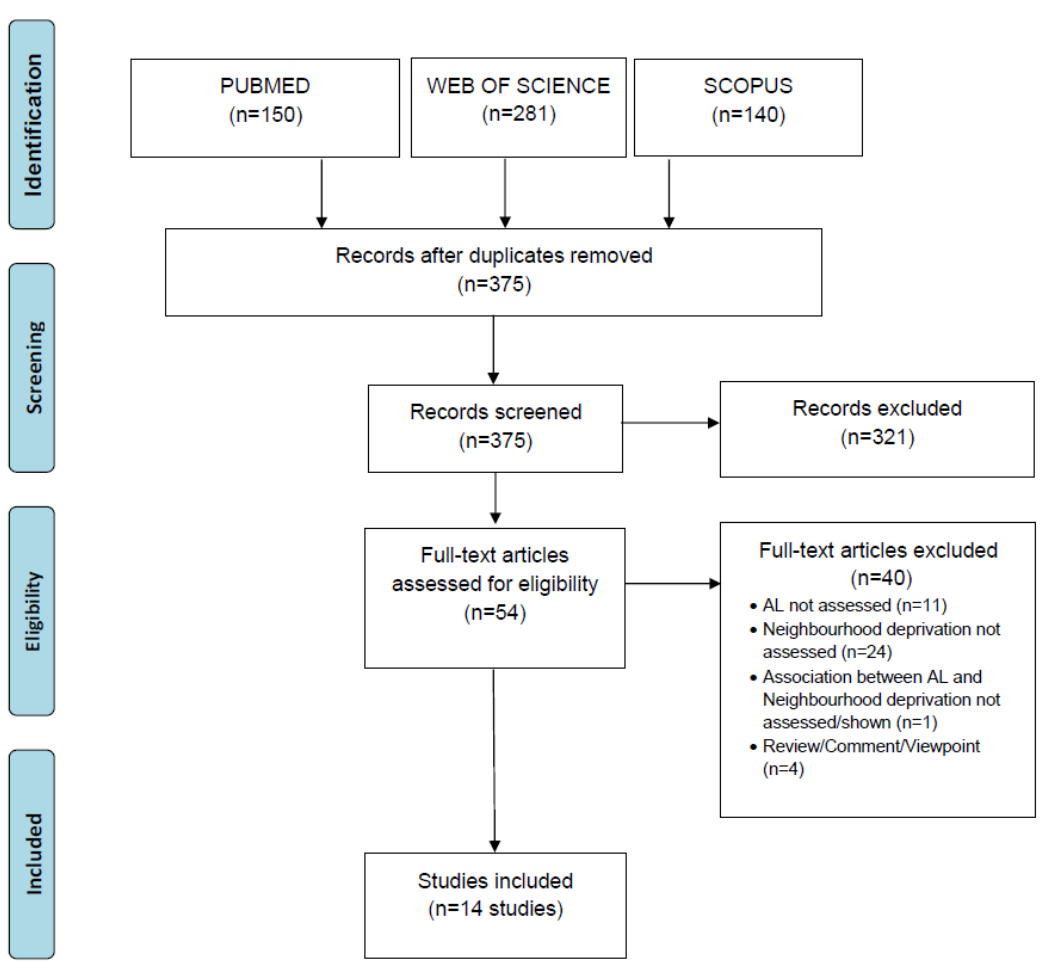
Figure 1. PRISMA diagram of the study selection process.